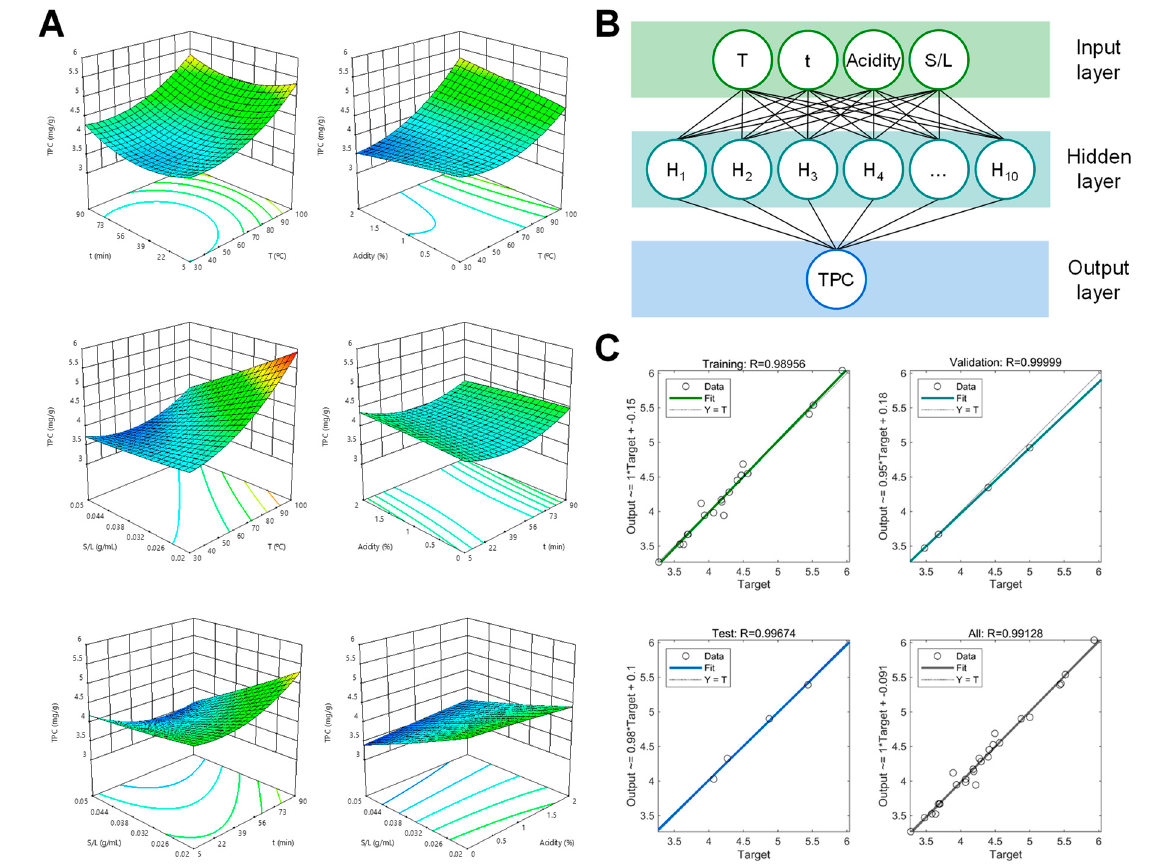
Figure 2. Representative 3D plots illustrating the behavior of total phenolic compounds (TPC) extraction ( A ). Responses (mg g − 1 ) are graphed against two paired variables: T (temperature in °C), acidity (% citric acid), t (time in min) and S/L (solid:liquid ratio in g mL − 1 ); the topology of the multilayer feed-forward neural network for TPC ( B ), and scatter plot between the experimental and predicted yield by artificial neural networks (ANNs) for training, validation, testing, and overall data fitting for TPC ( C ).